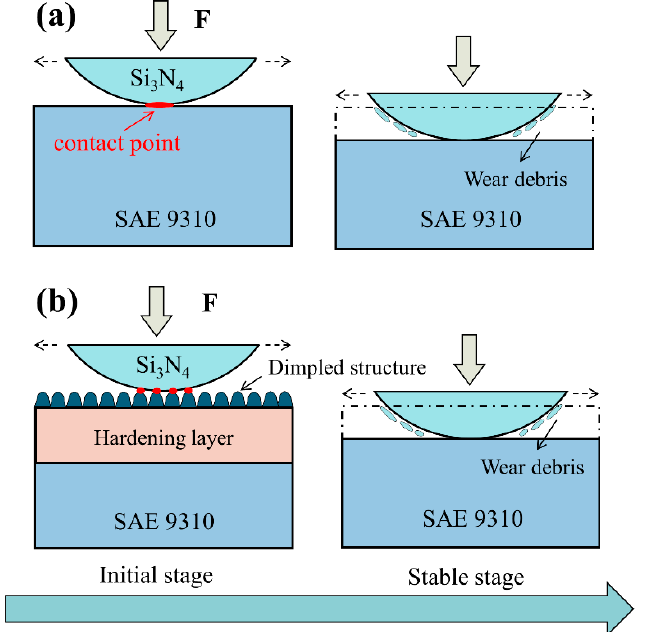
Figure 12. Schematic illustrations of the wear resistance improvement mechanism of Micro-LSP ( a ) pre-strengthening; ( b ) after strengthening.